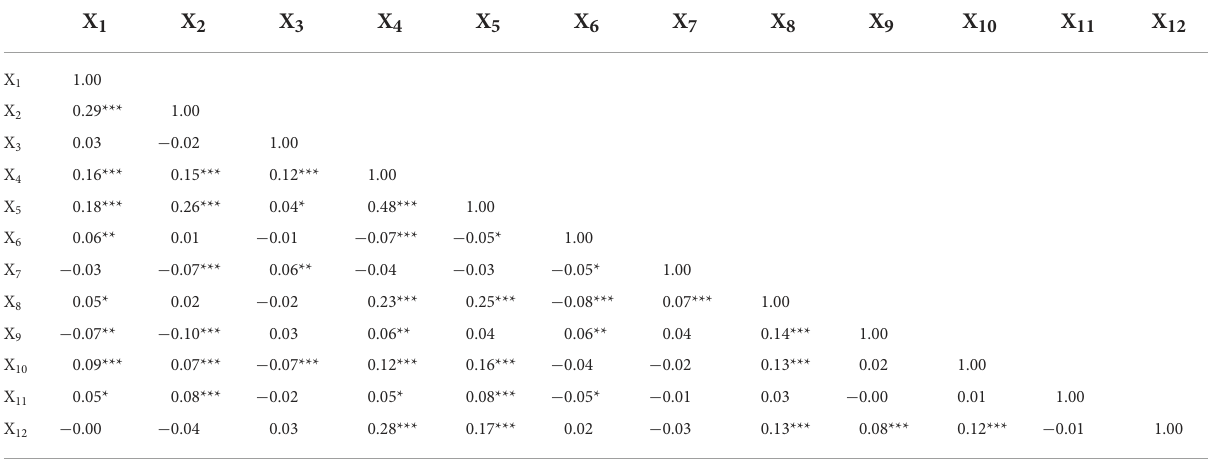
TABLE 2 Correlation analysis ( N = 2,283).